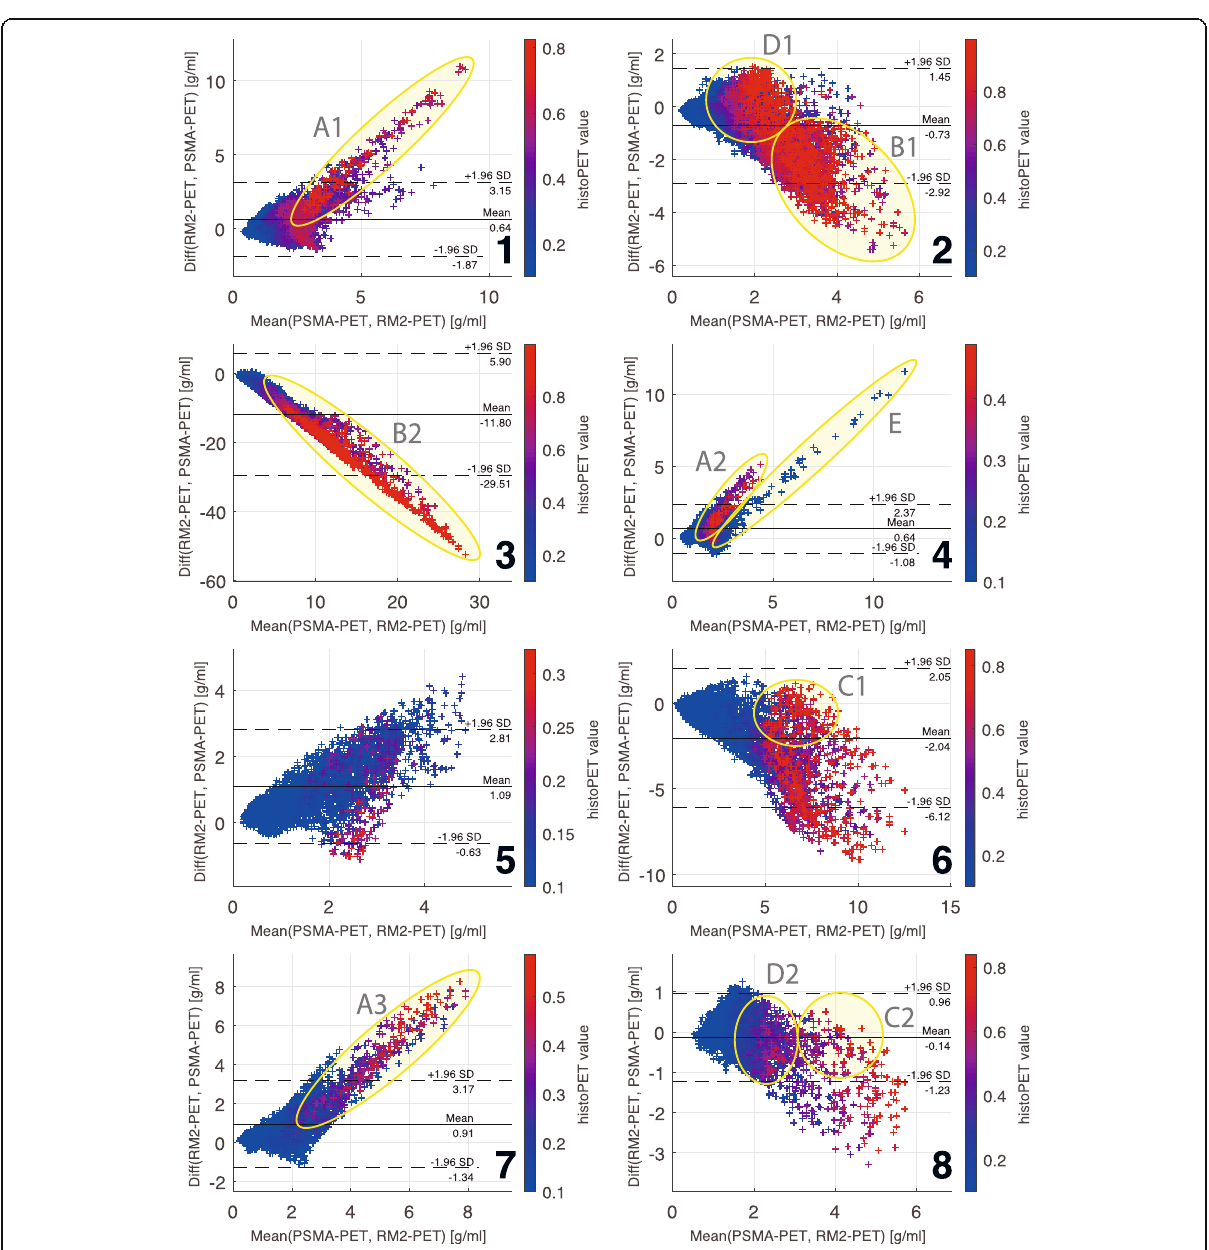
Fig. 4 Bland-Altman plots of a voxel-based comparison of each patient ’ s [ 68 Ga]Ga-RM2-PET SUV and [ 68 Ga]Ga-PSMA-PET SUV values. The color scale implies the corresponding histoPET relSUV value of each voxel. Areas of interest for a qualitative analysis are marked with a yellow circle and labeled with capital letters and numbers. See the “ Discussion ” section for a detailed explanation of these